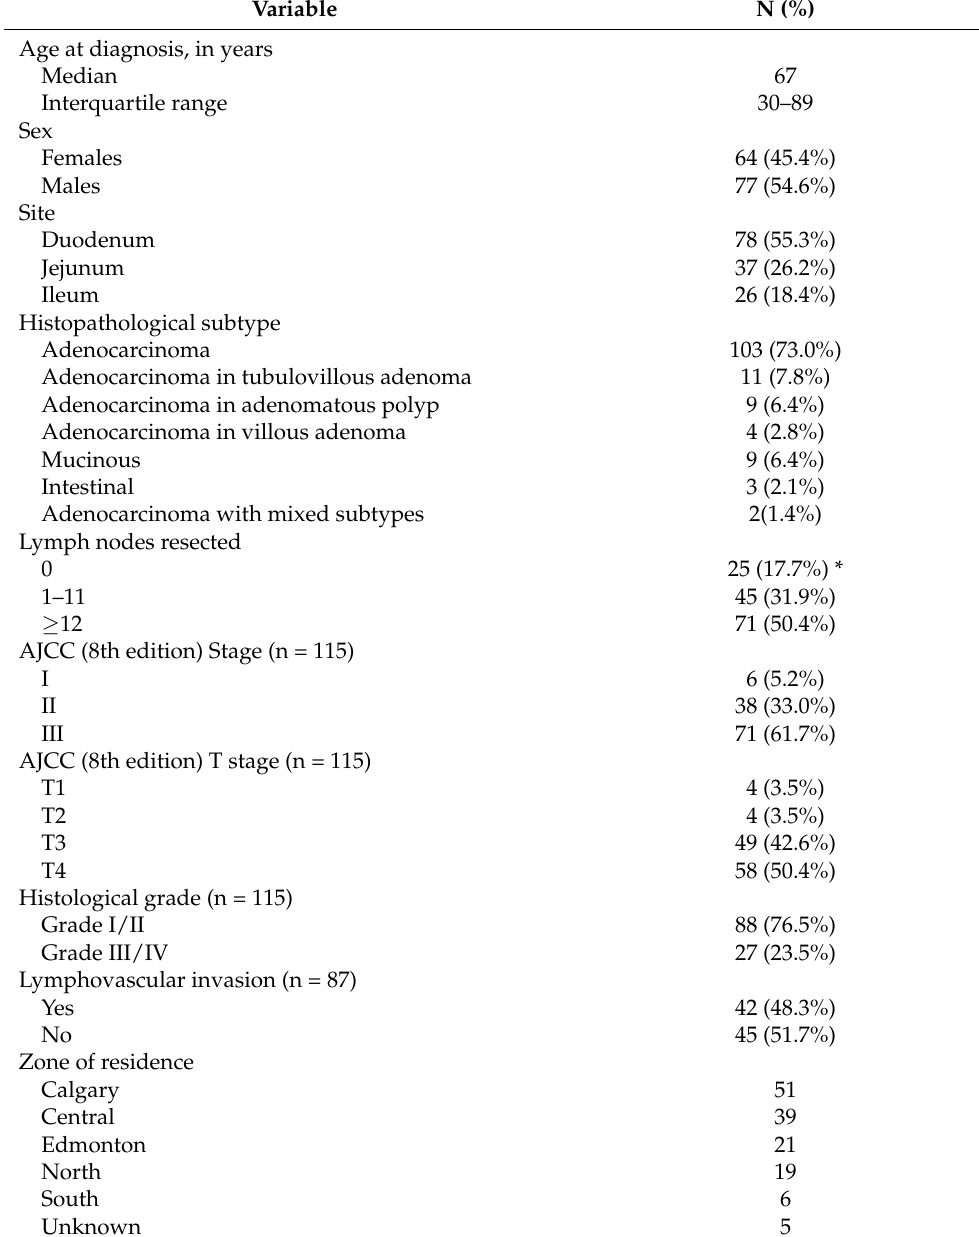
Table 1. Baseline characteristics of patients with non-metastatic small bowel cancer (n =